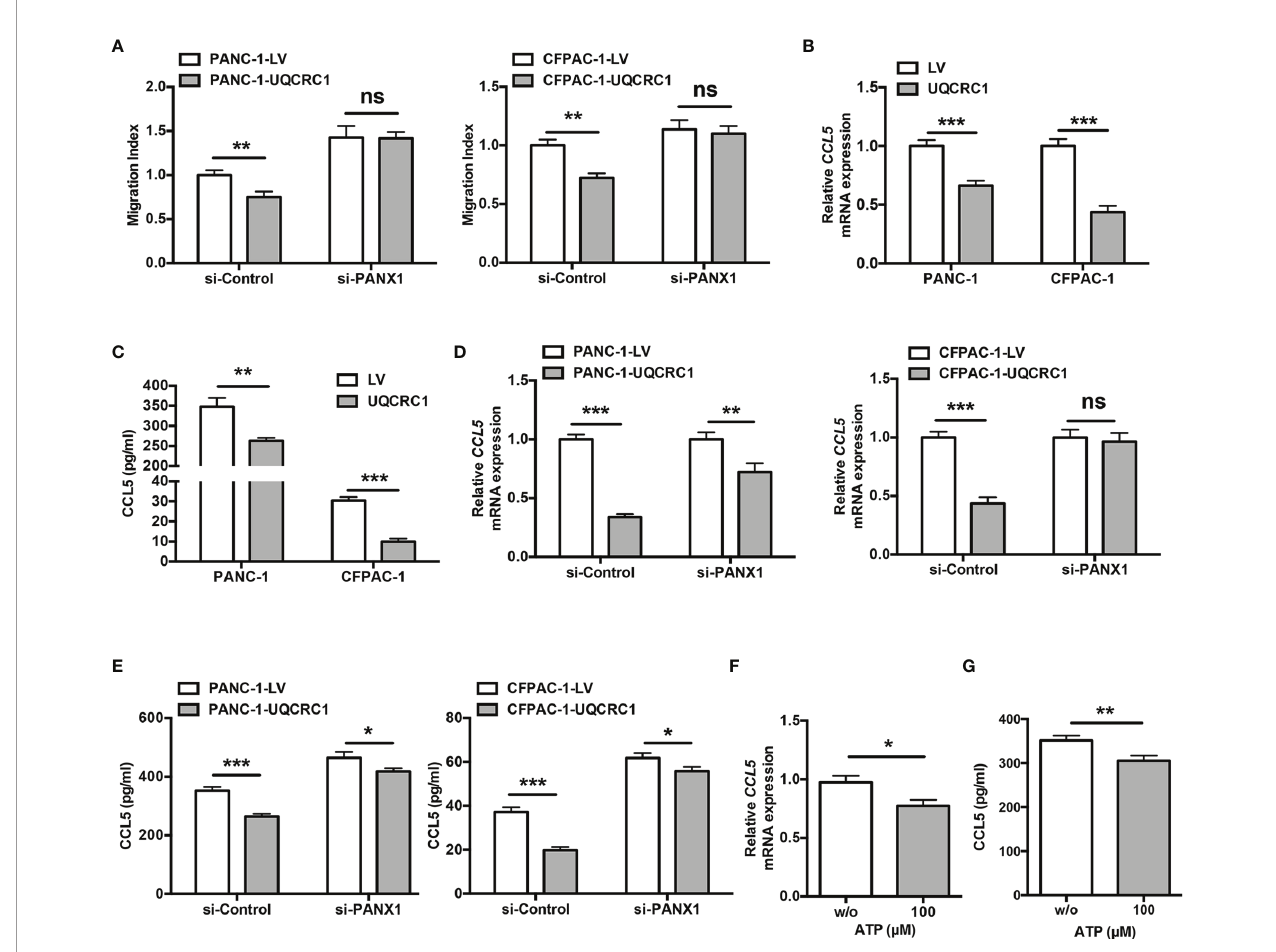
FIGURE 6 | UQCRC1/eATP axis impairs NK cell chemotaxis via decreasing CCL5 expression in PC cells. (A) The transwell migration assay of NK-92MI cells toward the culture supernatant from si-PANX1-transfected UQCRC1-overexpressing or control PC (PANC-1 or CFPAC-1) cells. (B) Relative mRNA levels of CCL5 in UQCRC1-overexpressing and control PC cells. (C) ELISA assay of CCL5 levels in culture supernatant of UQCRC1-overexpressing and control PC cells after 24 h of incubation. (D) The relative mRNA levels of CCL5 in UQCRC1-overexpressing or control PC (PANC-1 or CFPAC-1) cells after PANX1 knockdown. (E) ELISA assay of CCL5 levels in culture supernatant of UQCRC1-overexpressing and control PC cells after PANX1 knockdown. (F) The relative mRNA levels of CCL5 in the parental PANC-1 cells after being treated with or without 100 m M ATP for 24 h. (G) ELISA assay of CCL5 levels in culture supernatant of parental PANC-1 cells after being treated with or without 100 m M ATP for 24 h. All data are presented as the mean ± SD (n = 3 independent biological replicates). *, p < 0.05; **, p < 0.01; ***, p < 0.001; ns, not signi fi